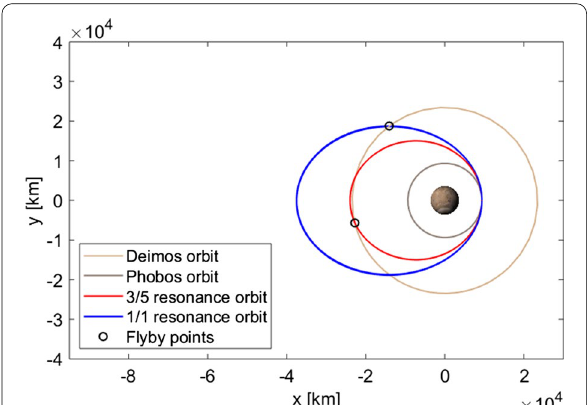
Fig. 17 Flyby orbits for Deimos observations with Mars centered. Example sequence: from an orbit with 3/5 resonance to an orbit with 1/1 resonance, before finally escape from Martian system. With respect to a fixed Mars, the Sun appears to rotate in the counter‑clockwise direction and the spacecraft revolves in clockwise direction